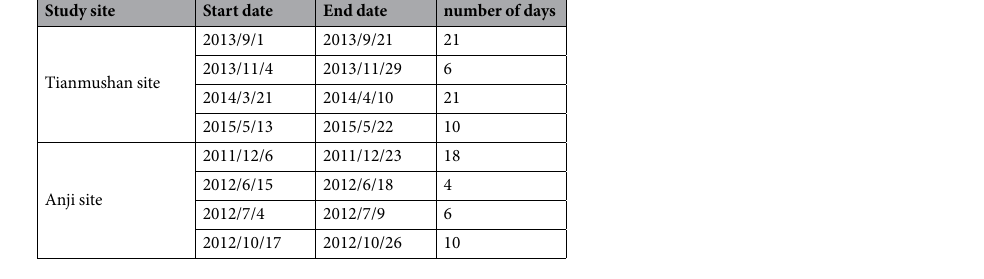
Table 1. The dates of the wireless sensor observations in this